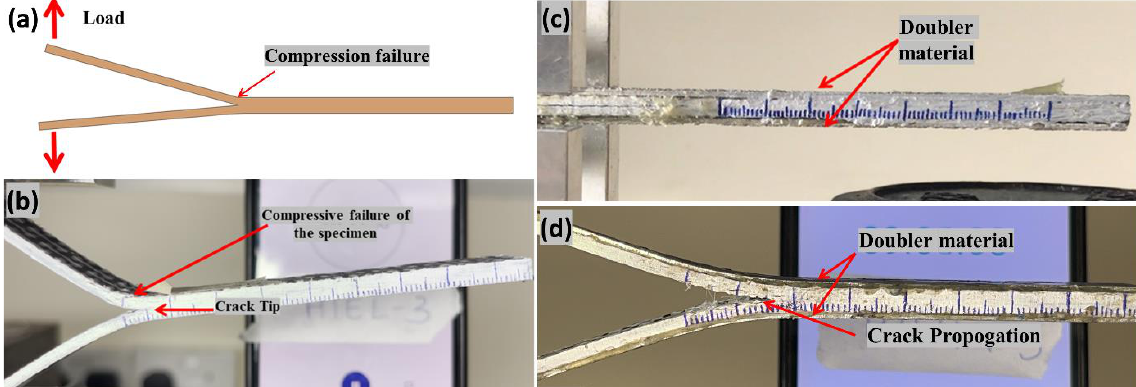
Figure 4 . ( a , b ) Schematic and testing showing the compression failure of the specimen under Mode I testing without doubler respectively ( c ) Hybrid composite specimen with aluminum doubler ( d ) Mode I testing of the hybrid composite laminate with doublers .